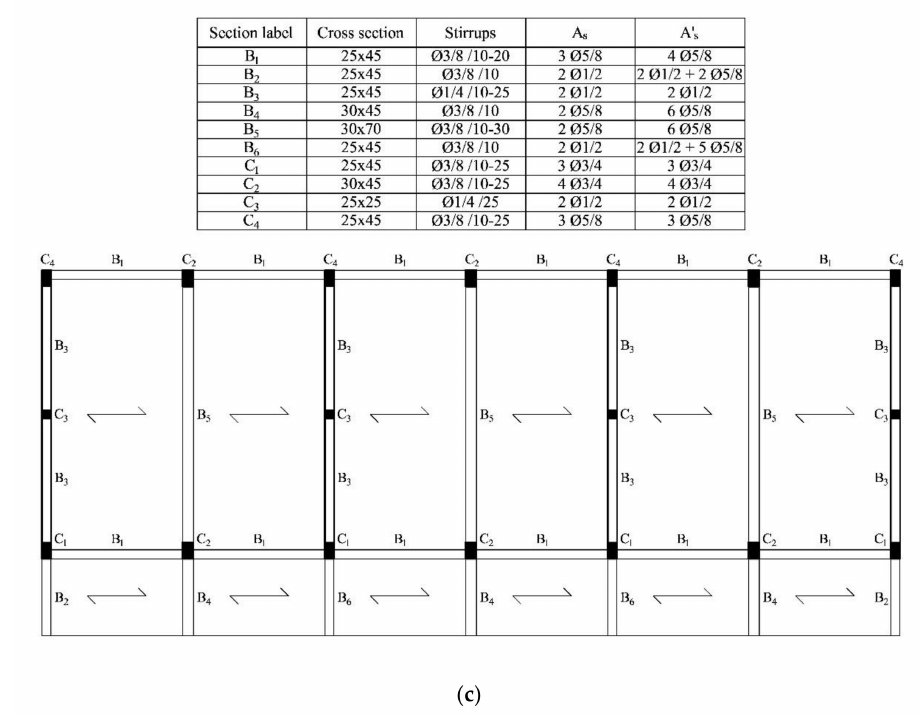
Figure 3. PREbuilding type: ( a ) Architectural layout; ( b ) Elevation view; ( c ) Structural